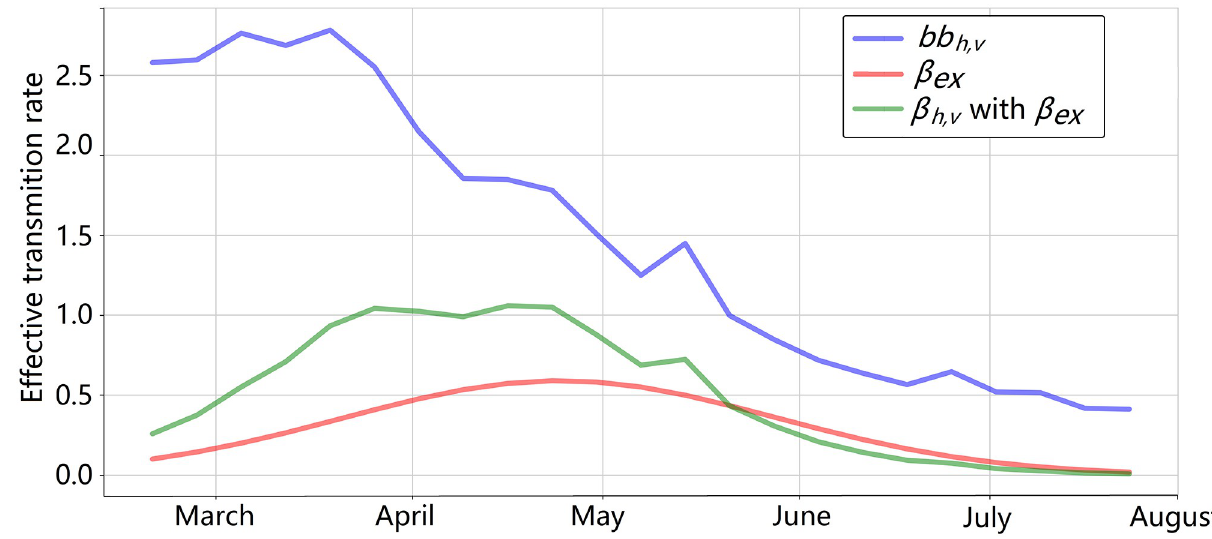
Fig 7. Curves of β